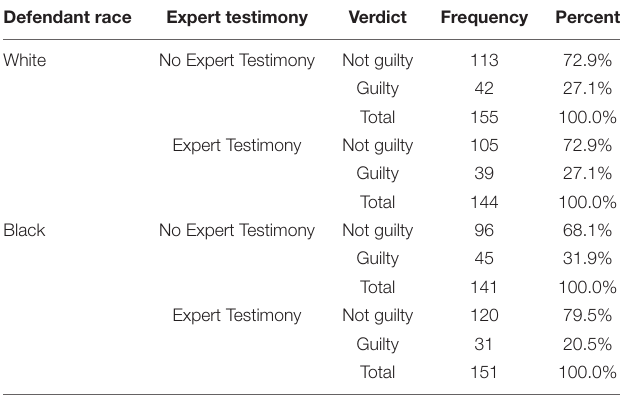
TABLE 4 | Percentage of not guilty verdicts by